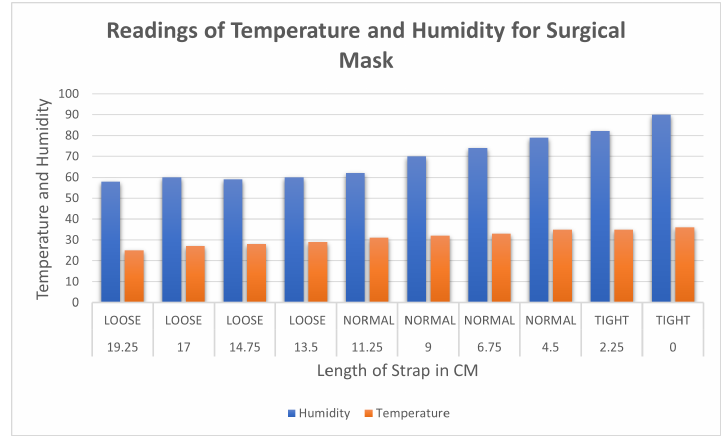
Figure 12. Variation of temperature in Celsius and humidity inside the surgical mask. Table 6. Temperature and humidity with varied tightness with a fabric mask.